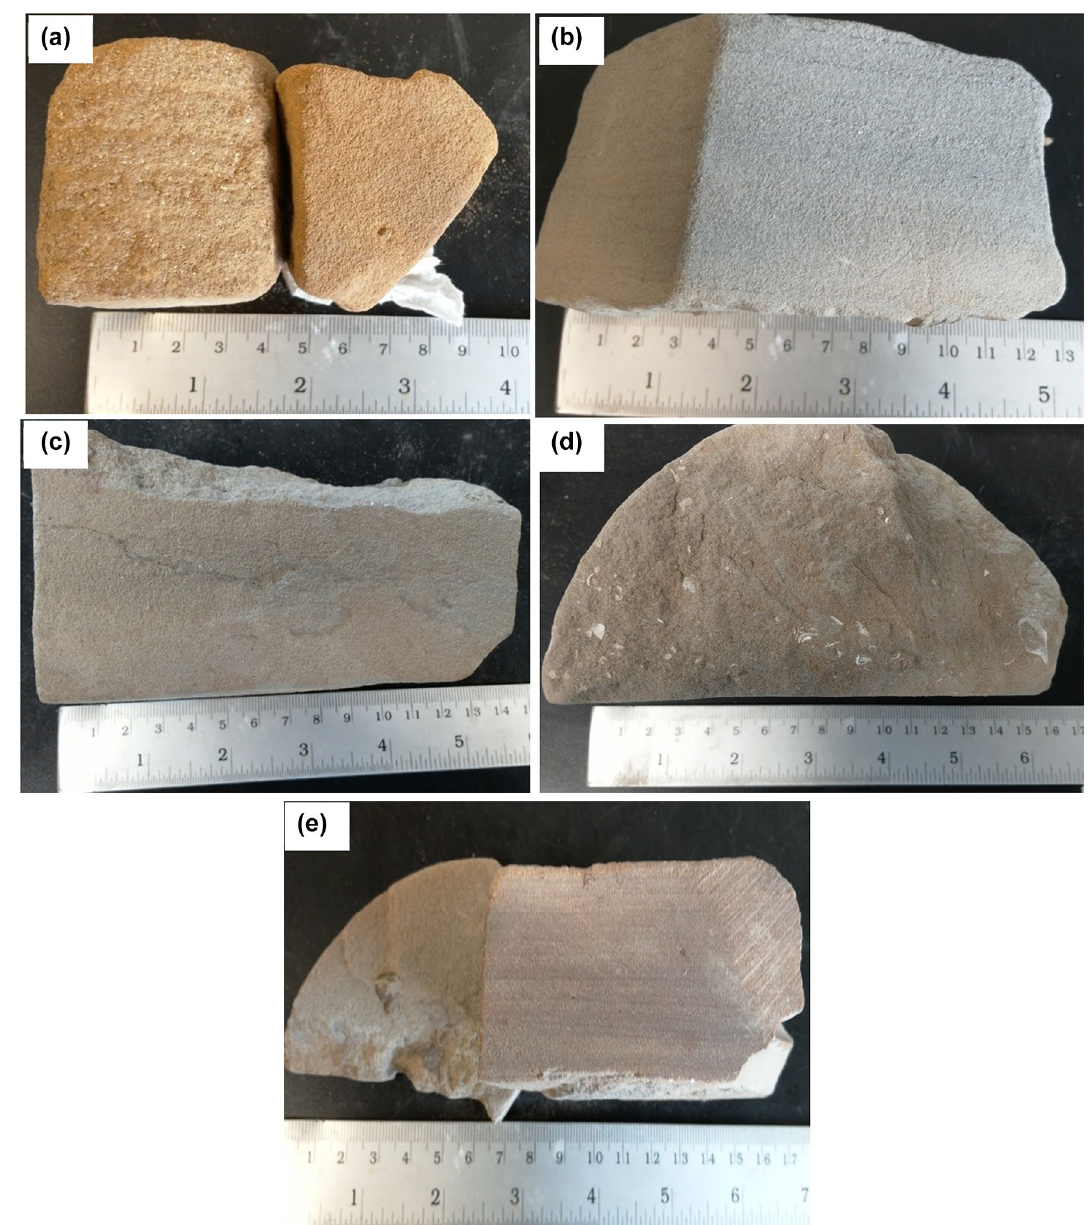
Fig. 3 Core specimen lithofacies. ( a ) Lithofacies 1: massive coarse- grained sandstone (MCGS), ( b ) Lithofacies 2: massive medium- grained sandstone (MMGS), ( c ) Lithofacies 3: massive fine-grained